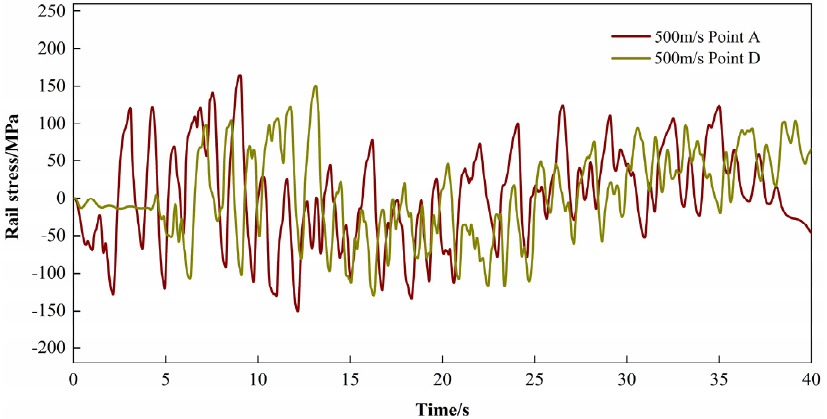
Figure 13. The stress–time-history curve of the rail at point A and point D when the apparent wave velocity is 200 m/s.